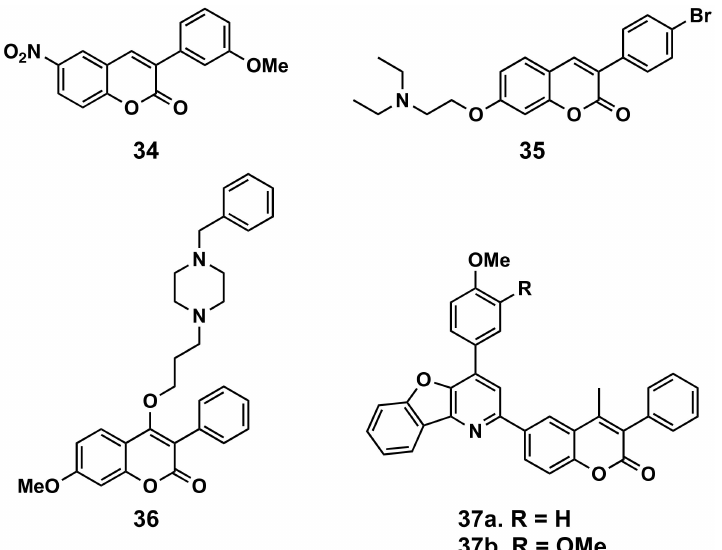
Figure 16. 3-Phenylcoumarins as antimicrobial agents.